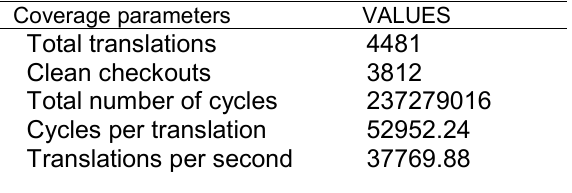
Table 2. Statistics collected by coverage tool with